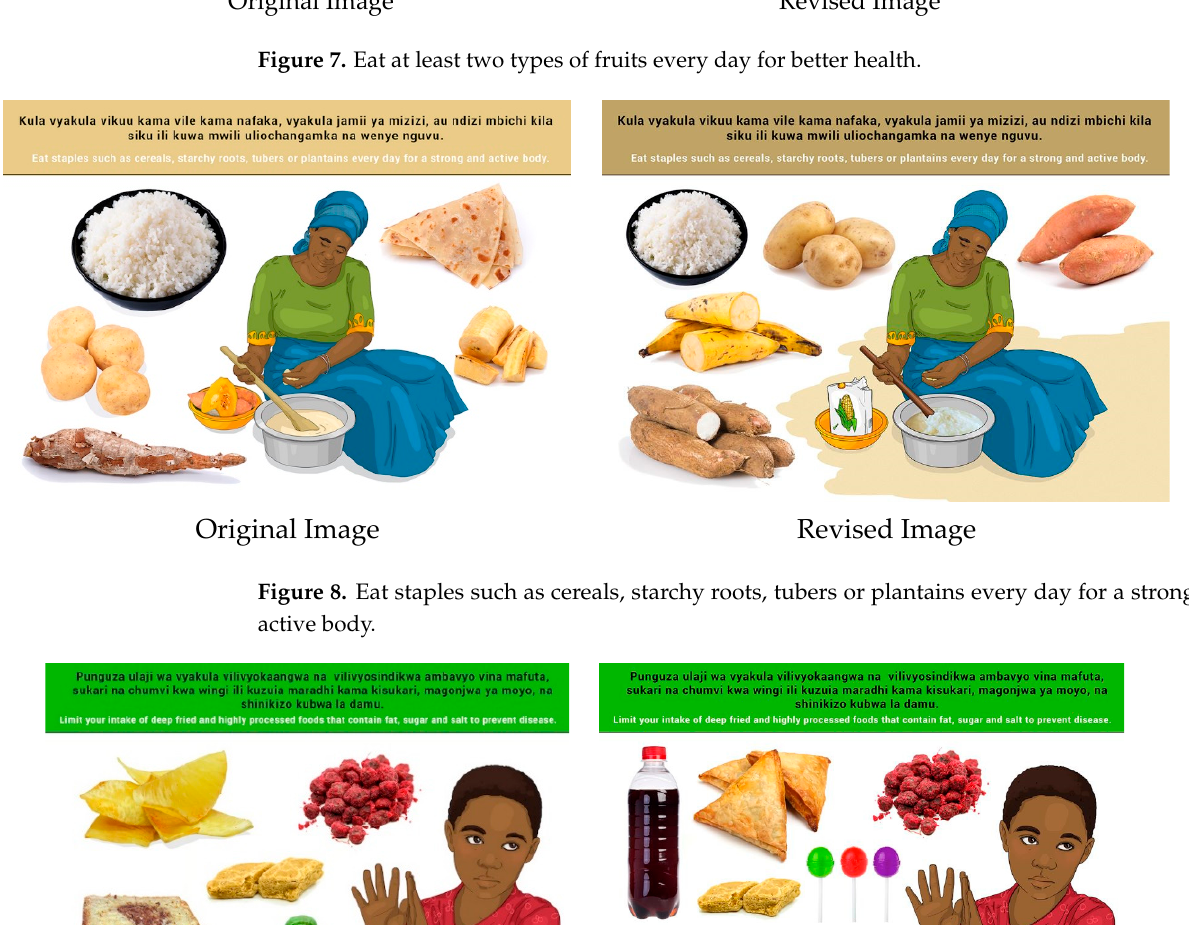
Figure 7. Eat at least two types of fruits every day for better health.